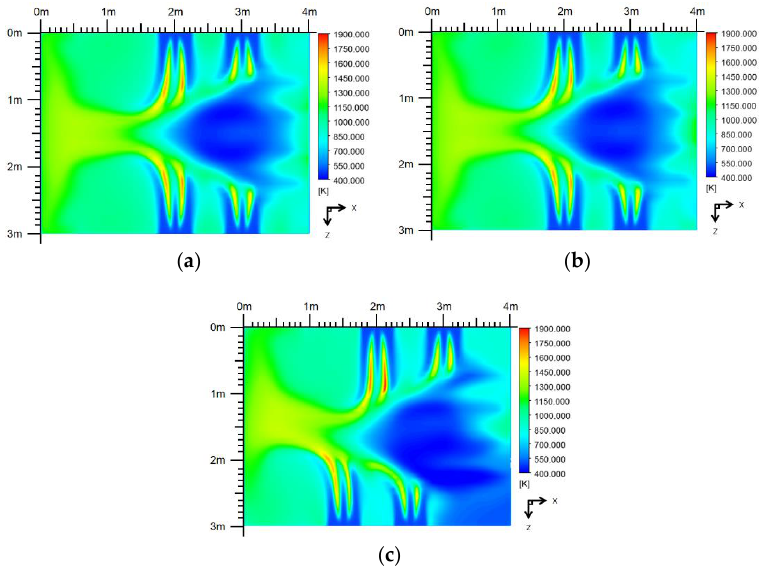
Figure 7. Temperature cloud diagram of the central cross-section of the first combustion chamber (Y = 0.75 m). ( a ) Symmetrical arrangement of burners with re-verse swirl; ( b ) symmetrical arrange- ment of burners with same direction flow; ( c ) burner-staggered arrangement with same direction flow.